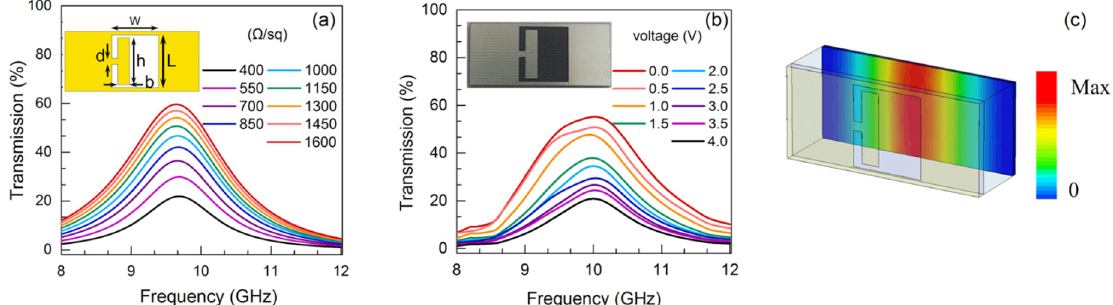
Fig. 3. (a) Calculated and (b) measured transmission spectra of the hybrid metasurface with metallic cut-wire structure by changing the sheet resistance from 400 to 1600 V sq (cid:3) 1 , the external bias voltage changes from 0 to 4 V in experiments. The inset in (a) shows the schematic of the cut-wire structure and the inset in (b) shows a fabricated sample. The geometric parameters are: L =9mm, W =8 mm, h= 8mm, b=2 mm, and d= 1mm. (c) Energy loss distribution of the hybrid metasurface at frequency 10.3GHz with a sheet resistances of 1600 V sq (cid:3) 1 .